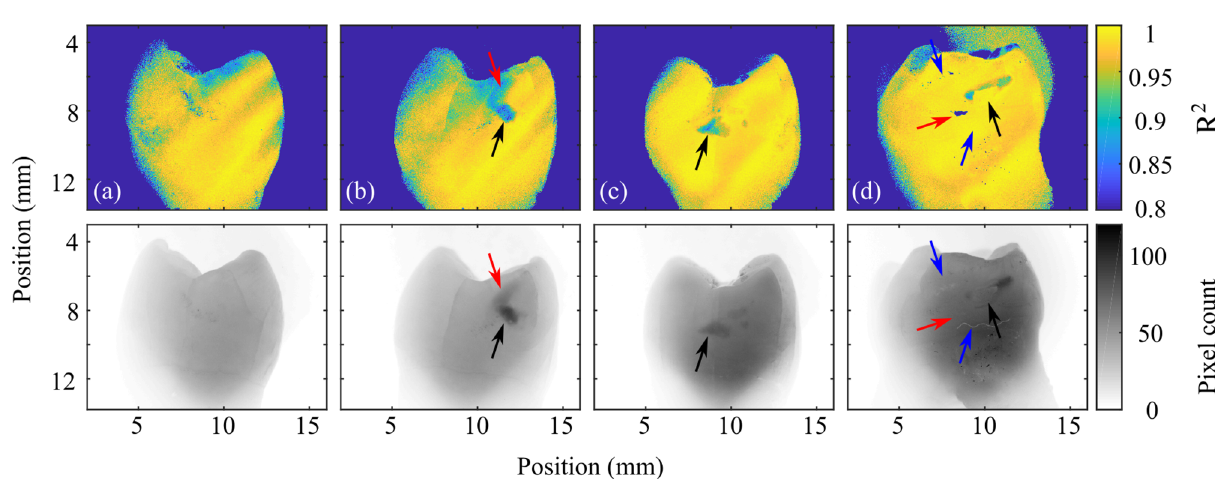
Figure 4. Quality of fit (top) and uniform illumination images